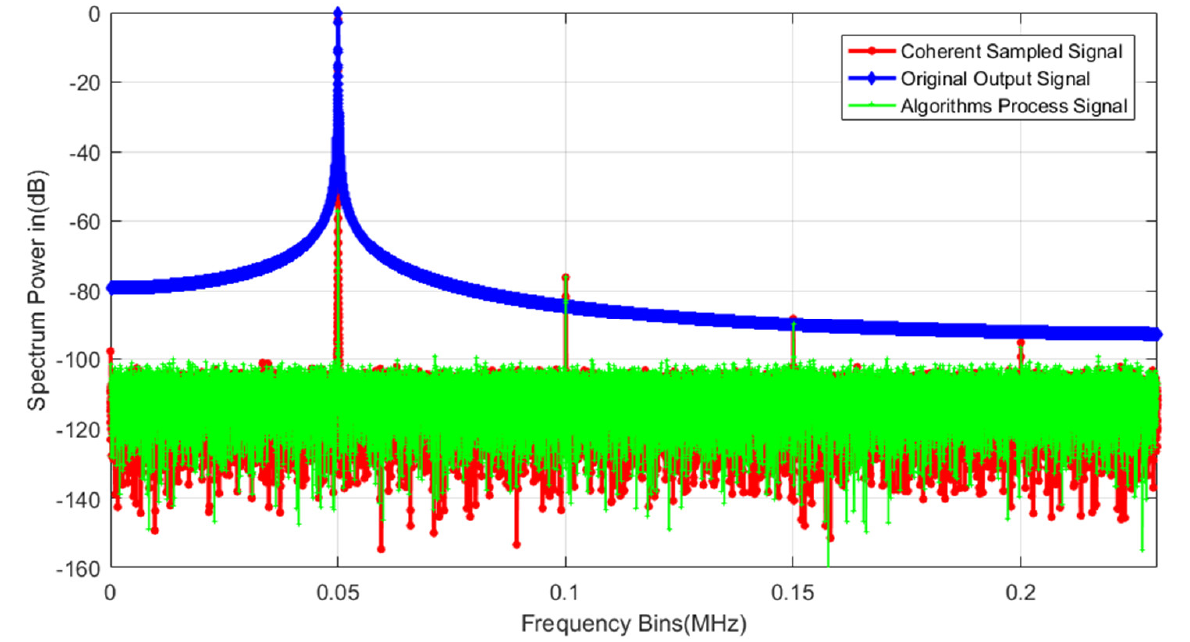
Figure 5. The simulated spectrum of a 16-bit ADC under three sets of conditions (original, coherently sampled, and after processing with the proposed algorithm).